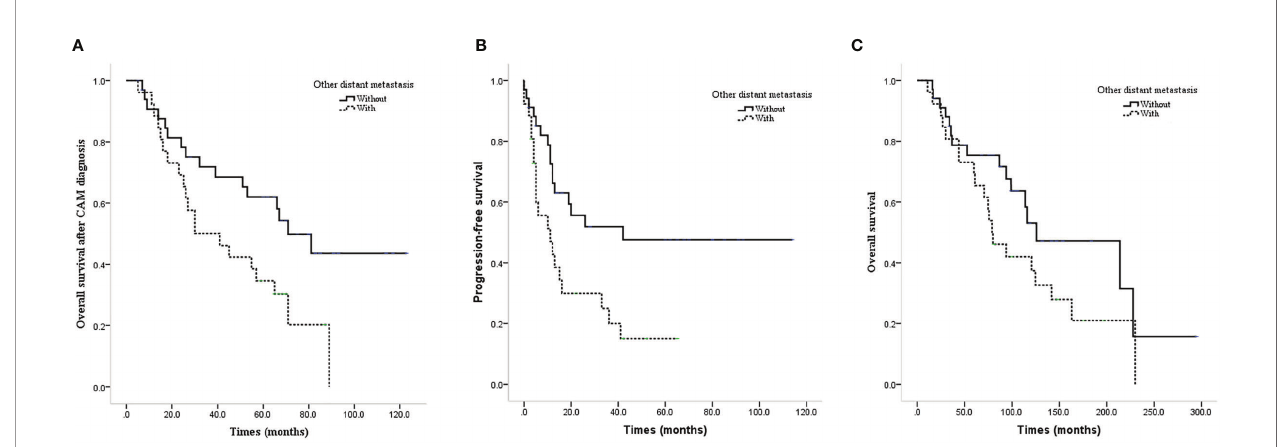
For the isolated CAM patients, 22 patients developed tumor progression after CAM treatment with a mean PFS of 34.4 months, and 18 patients survived during the follow-up. The fi ve-year survival rate of isolated CAM patients was 67.4%, and the fi ve-year disease-free survival (DFS) rate was 52.9%. ALND or low-middle level ALND signi fi cantly improved the OS (mean OS 237.4 vs. 111.0 months, P=0.011; Figure 3A ), CAM-OS (mean CAM-OS 105.2 vs. 46.6 months, P = 0.002; Figure 3B ), and PFS (mean PFS 92.3 vs. 26.9 months, P = 0.001; Figure 3C ) of isolated CAM patients. Axillary radiotherapy improved PFS, CAM-OS, and OS but without a signi fi cant difference (mean PFS 80.0 vs. 46.6 months, P = 0.345; mean CAM-OS 86.8 vs. 72.1 months, P = 0.338; mean OS 147.6 vs. 133.0 months, P = 0.426; Figures 4A – C ).